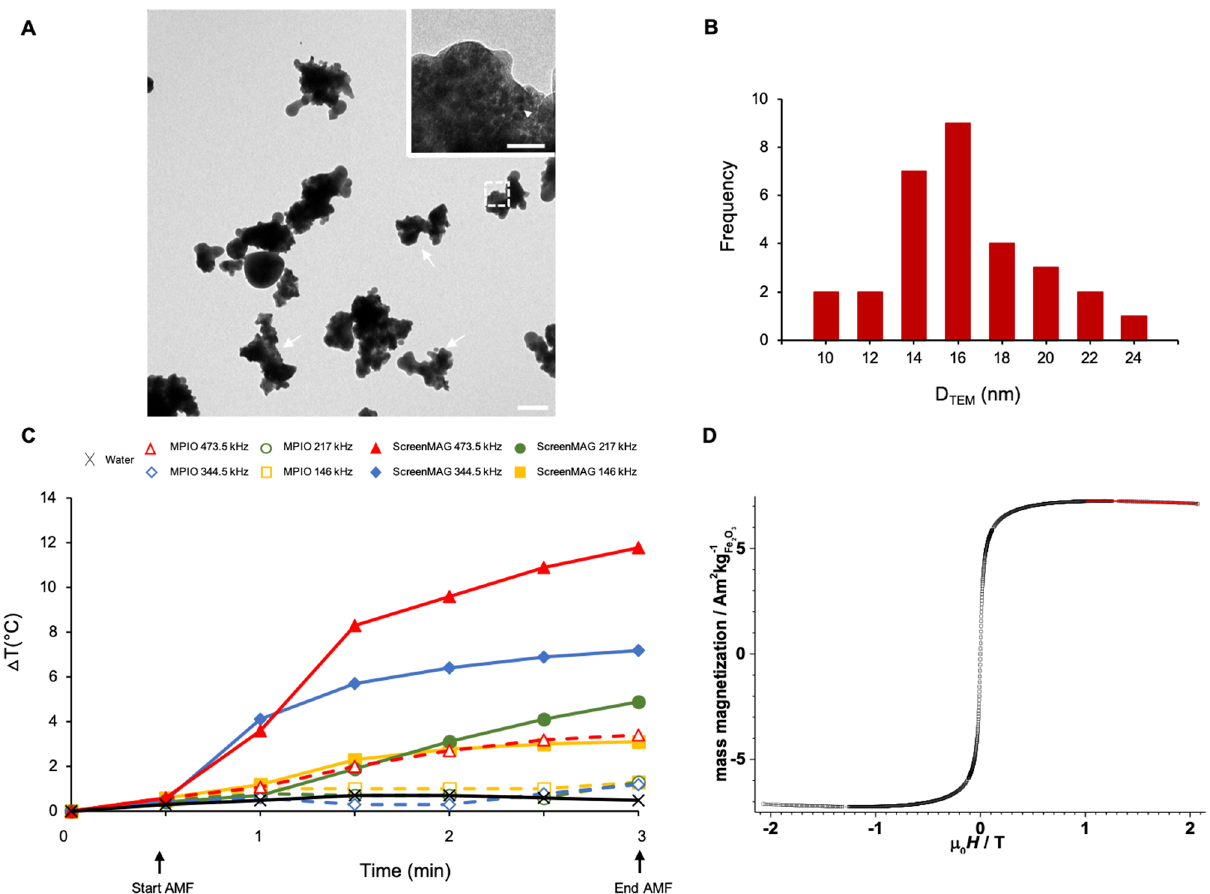
Figure 1. Characterization of the commercial micrometric iron oxide particles ScreenMAG (carboxyl- functionalized magnetic fluorescent silica particles; λ exc = 502 nm; λ em = 525 nm). ( A ) Transmission electron microscopy (TEM) images of ScreenMAG. Sizes and shapes were observed in negative staining. White arrows indicate one iron oxide particle. Particles are assembled as multi-iron oxide cores inside a matrix. White head arrows show single iron oxide cores. Scale bar: 500 nm (insert: 100 nm). ( B ) Histogram of the iron core diameters determined by TEM. ( C ) Temperature elevation curves of aqueous suspensions of MPIO or ScreenMAG at 57 mM Fe after application of an alternating magnetic field (AMF) at different combinations of frequencies and amplitudes: 146 kHz, 21.90 kA m −1 ; 217 kHz, 20.69 kA m −1 ; 344.5 kHz, 16.23 kA m −1 and 473.5 kHz, 13.36 kA m −1 . ( D ) Field dependence of the mass magnetization of ScreenMAG at 296 K (black squares). The law of approach fit is reported as a red line. The electromagnet soft iron poles separation was reduced to 5 mm to allow maximum field (2.1 T). Samples were weighed accurately with a Mettler MX5 microbalance. 30 µL of the ScreenMAG stock solution was sealed in a light tin capsule for liquid samples for elemental analysis. An empty capsule was measured beforehand and the resulting diamagnetic contribution convoluted with the quartz rod was accordingly subtracted from the measurements. Magnetization values were normalized respectively to the Fe cation content (265 mM) as determined by ICP analysis: 30 µL corresponding thus to 0.444 mg of Fe and 0.635 mg of Hysteretic measurement of the ScreenMAG particle suspension evidences superparamagnetic behavior at room temperature (Fig. 1D), with saturation effective above 0.5 T. The fit, reported in red in Fig. 1D, gave a satu- − 1 ration value M S of 7.69 ± 0.02 Am 2 kg Fe 2 O 3 (0.1178 ± 0.0002 μ B /Fe). This magnetization is significantly lower than − 1 the values found in the bulk (60–80 Am 2 kg Fe The ScreenMAG colloidal dispersion was measured using Dynamic Light Scattering (DLS), and proved to be stable for 1 h with a mean hydrodynamic diameter averaging during that period of 774 ± 151 nm (Supplementary Data S3B), which is in agreement with the global size of the particles measured in TEM. The measured Z-average diameter started to decrease approximately linearly over time, with a rate of about 0.2 nm s −1 . Concomitantly, the mean backscattered light intensity was constant for 1 h (mean: 2157 ± 94 kcounts s −1 ) and then started to decrease. A decay time was estimated graphically at 10,800 s, meaning the characteristic sedimentation time of the dispersion is approximately 3 h.